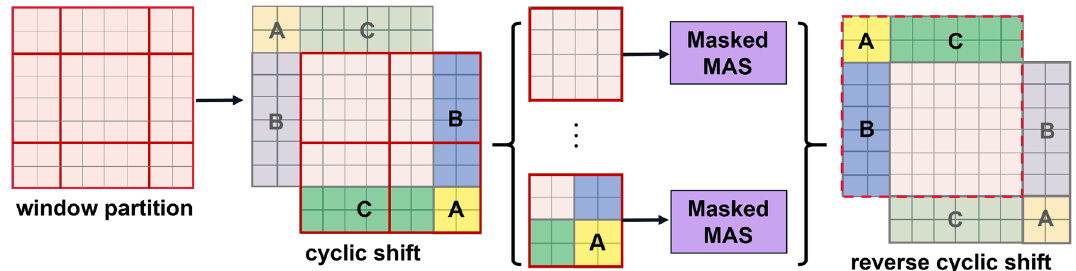
Figure 4. Efficient batch computation approach for self-attention in shifted window